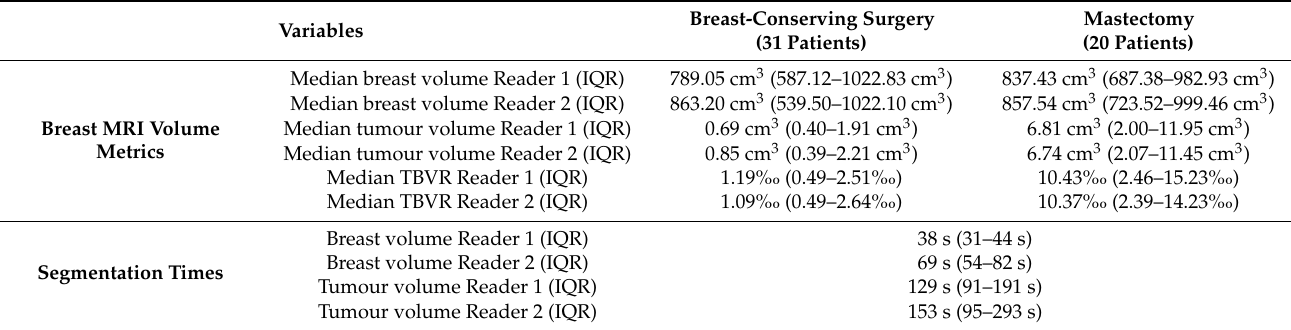
Table 3. Breast magnetic resonance volume metrics and segmentation times across the patient